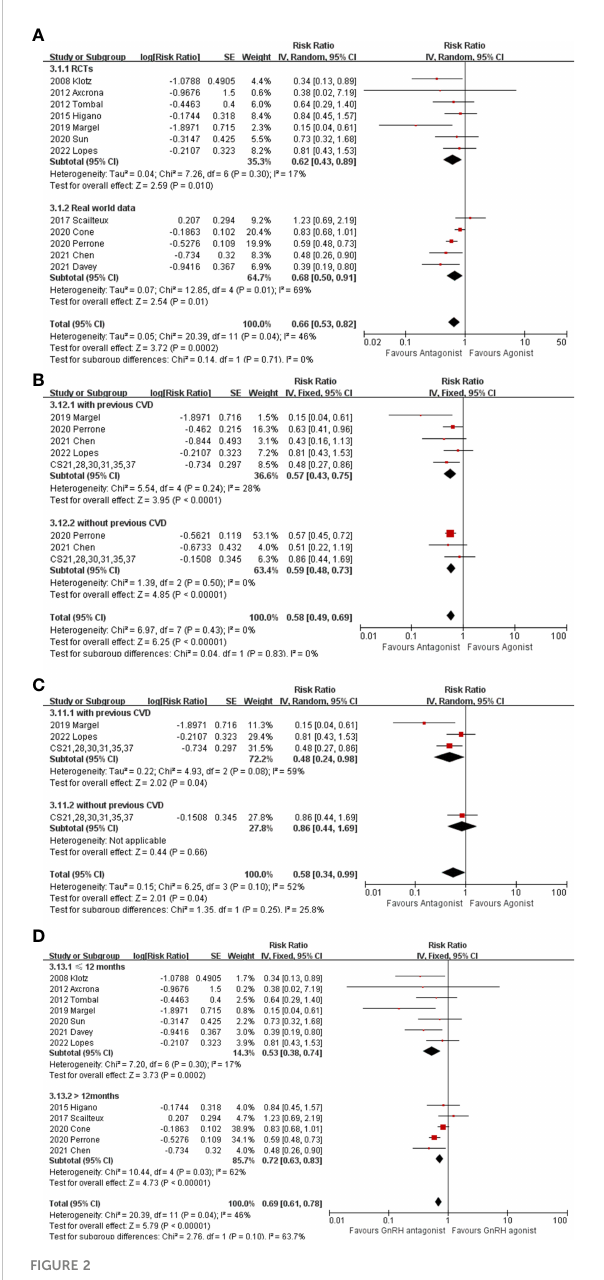
FIGURE 2 (A) The forest plot of CV events in RCTs and real-world data. (B) The forest plot of CV events strati fi ed with preexisting CV disease. (C) The forest plot of CV events strati fi ed with preexisting CV disease in RCTs. (D) The forest plot of CV events strati fi ed with follow-up period. The boxes, lines and rhombus represent RR (or HR), 95% CI of each study and the pooled RR along with 95% CI,